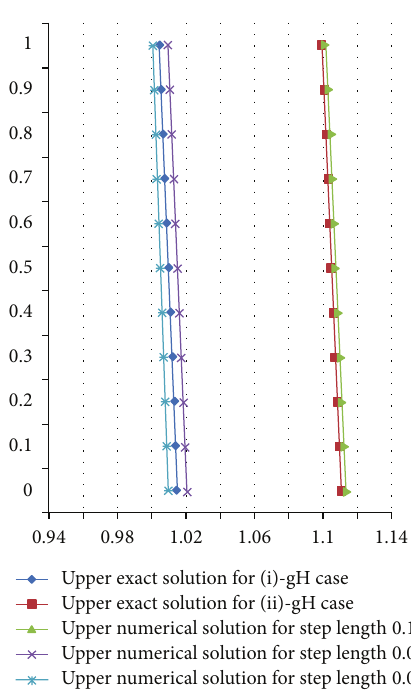
Figure 2: Comparison of upper exact solutions and numerical solution for different step lengths at 𝑡 = 0.1